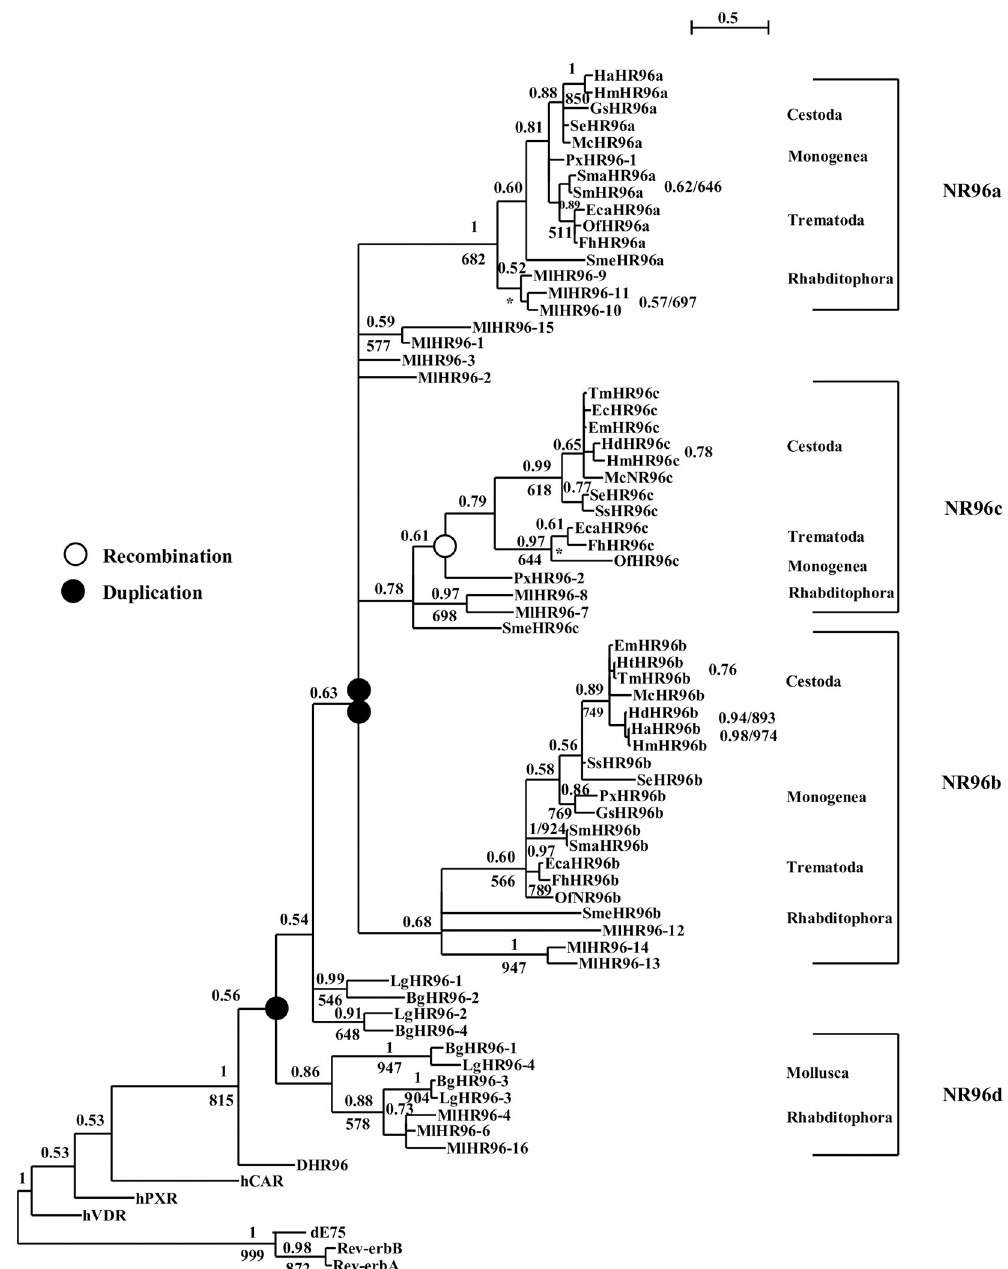
Fig 4. Bayesian phylogenetic tree of Platyhelminth HR96s. ML model tested as JTT+G+I (Equilibrium frequencies: Model, Proportion of invariable sites: estimated (0.149), Number of substitution rate categories: 4, Gamma shape parameter: estimated (0.727). Bg: Biomphalaria glabrata , Cs: Clonorchis sinensis , d: Drosophila melanogaster , Dl: Dibothriocephalus latus , Ec: Echinococcus Canadensis , Eca: Echinostoma caproni , Eg: Echinococcus granulosus , Em: Echinococcus multilocularis , Fh: Fasciola hepatica , Gs: Gyrodactylus salaris , h: Homo sapiens , Hd: Hymenolepis diminuta , Hn: Hymenolepis nana , Ht: Hydatigera taeniaeformis , Lg: Lottia gigantean , Mc: Mesocestoides corti , Ml: Macrostomum lignano , Of: Opisthorchis felineus , Ov: Opisthorchis viverrini , Px: Protopolystoma xenopodis , Sb: Schistosoma bovis , Sc: Schistosoma curassoni , Se: Spirometra erinaceieuropaei , Sh: Schistosoma haematobium , Sj: Schistosoma japonicum , Sm: Schistosoma mansoni , Sma: Schistosoma margrebowiei , Smt: Schistosoma mattheei , Sme: Schmidtea mediterranea , Sr: Schistosoma rodhaini , Ss: Schitocephalus solidus , Ta: Taenia asiatica , Tm: Taenia multiceps , Ts: Taenia saginata , Tr: Trichobilharzia regent , Tso: Taenia solium .